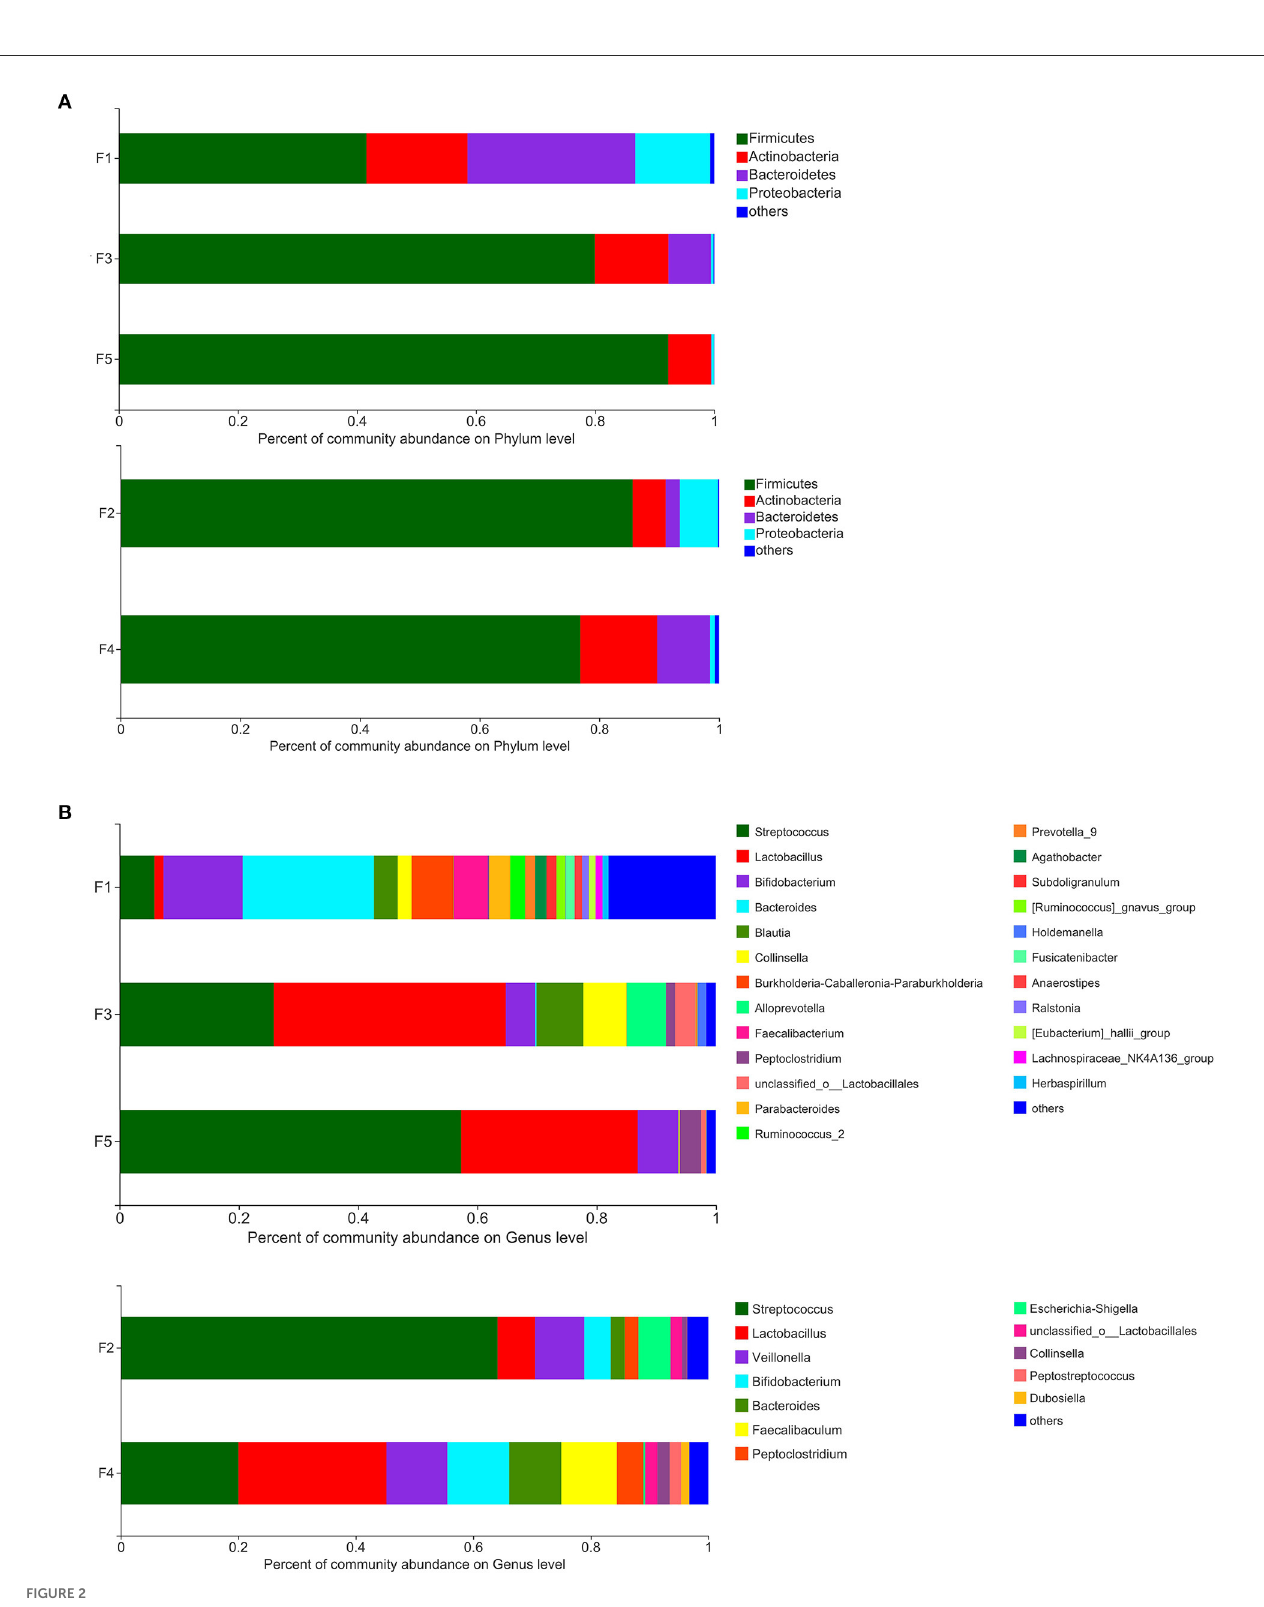
FIGURE2 Percent of community abundance of fecal microbiota of non-SPF and SPF beagles. Colored stacked bars indicate the identity of the dominant taxa. (A) Percent of community abundance on phylum level for the samples of F1 (newborn), F3 (1-month-old) and F5 (3-month-old) groups in non-SPF Beagle dogs and the samples of F2 (1-month-old) and F4 (3-month-old) groups in SPF Beagle dogs. (B) Percent of community abundance on genus level for the samples of F1 (newborn), F3 (1-month-old) and F5 (3-month-old) groups in non-SPF Beagle dogs and the samples of F2 (1-month-old) and F4 (3-month-old) groups in SPF Beagle